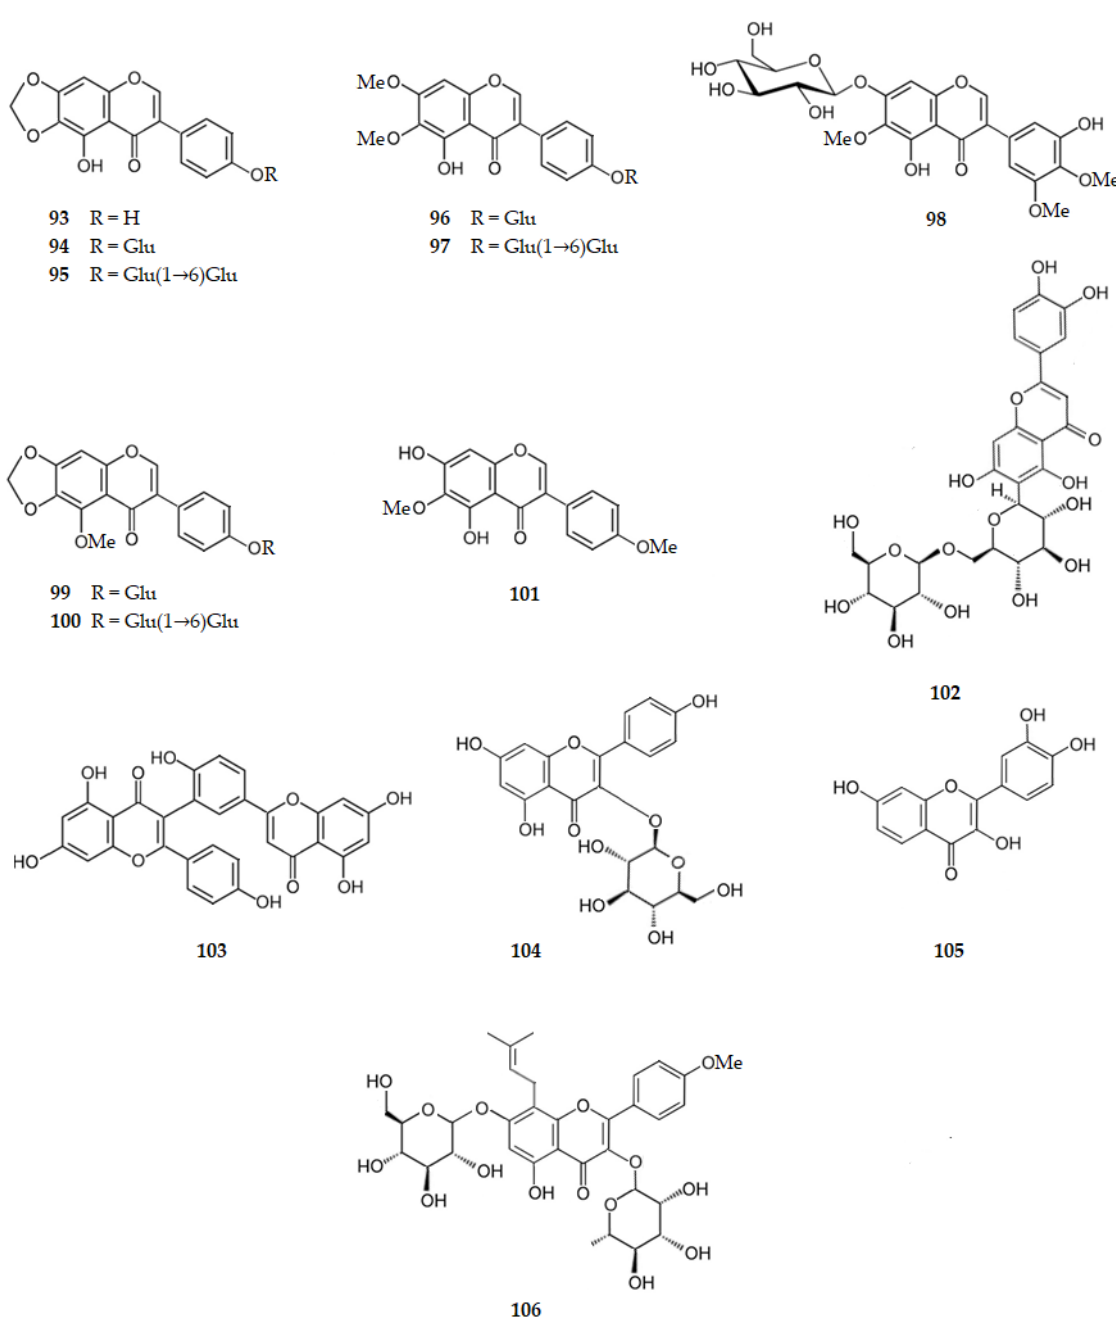
Figure 10. Structure of some flavonoids that inhibit the pro-inflammatory factors. Legend: Glu – glucopyranosyl.